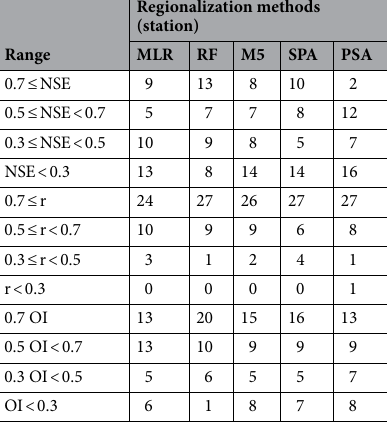
Table 6. The performance criteria of the analysis method for estimating